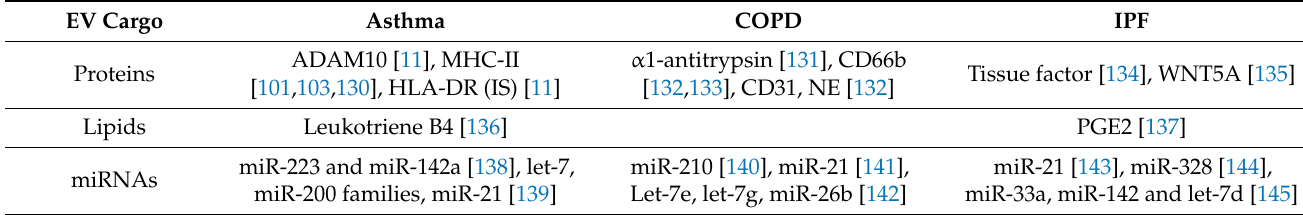
Table 1. Proteins, lipids and miRNAs contained in extracellular vesicles (EVs) that have been associated with asthma, chronic obstructive pulmonary disease (COPD) and idiopathic pulmonary fibrosis (IPF). EV Cargo Proteins